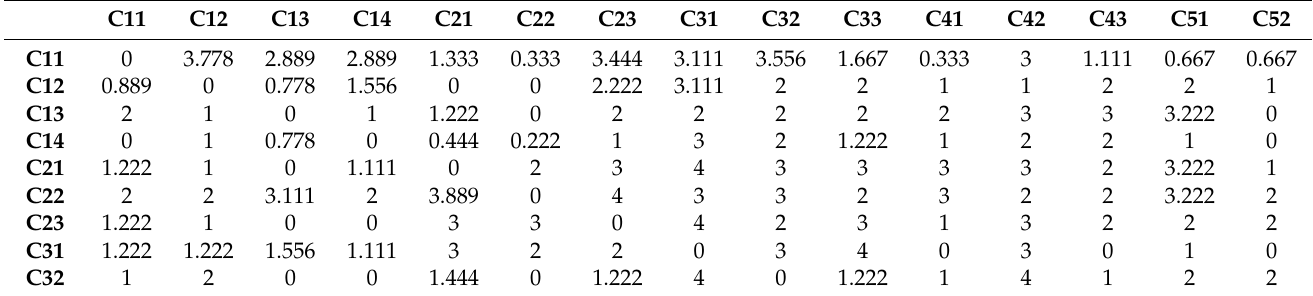
Table A4. Direct relation